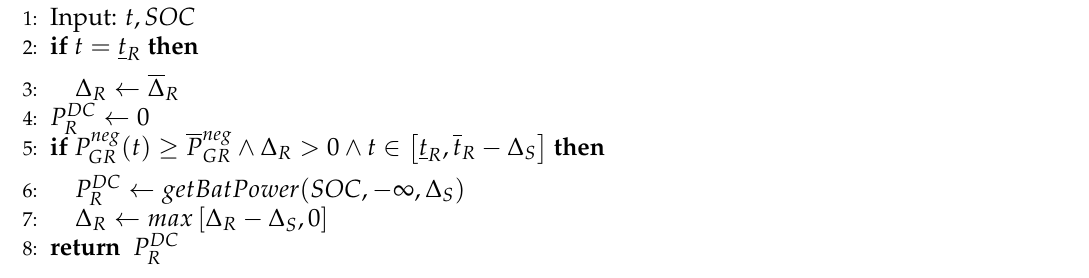
Figure 2. Algorithm of getReservePower ( t , SOC )